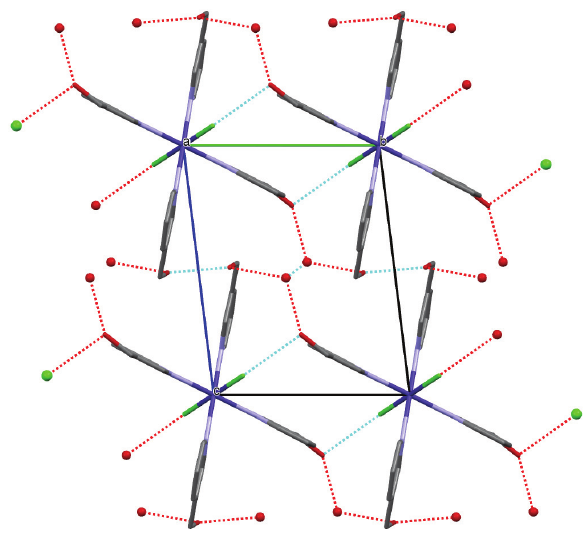
Figure 6. Three dimensional H-bonded network in 3 , viewed along a axis. D···A contacts are drawn as red dotted lines. Hydrogen atoms are